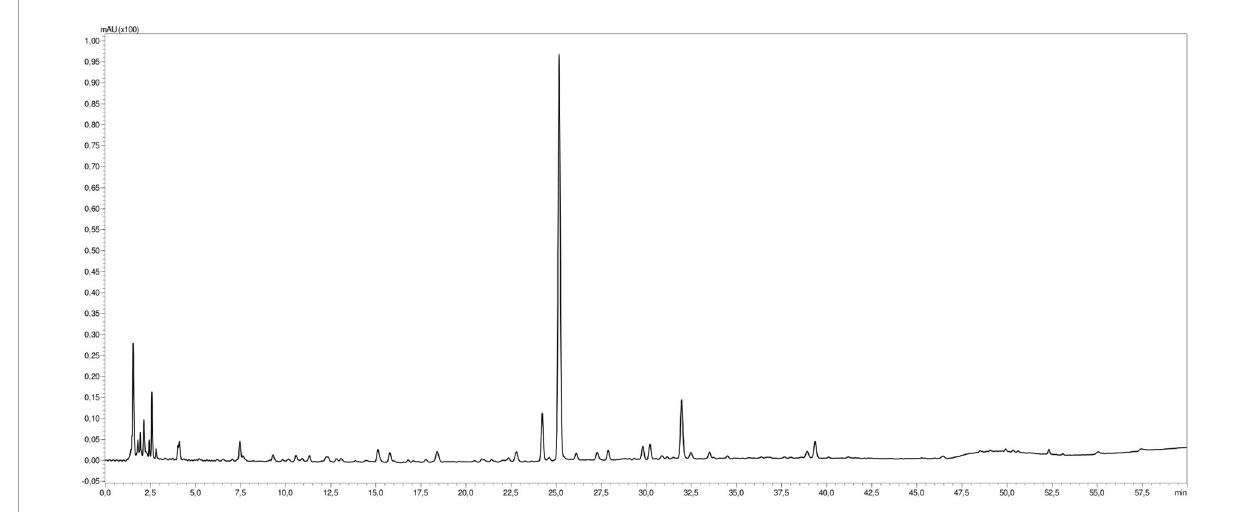
FIGURE2 Liquid chromatography profile of Mentha rotundifolia leaves aqueous